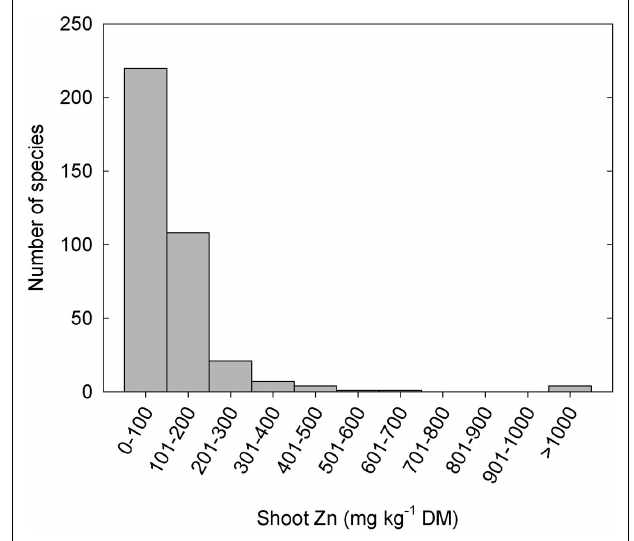
FIGURE 1 | Frequency distribution of mean zinc (Zn) concentrations in leaf or non-woody shoot tissues of 365 species from 48 angiosperm families grown under controlled conditions at non-toxic substrate Zn concentrations (Broadley et al., 2007). Data from 1108 studies were combined using residual maximum likelihood (REML)